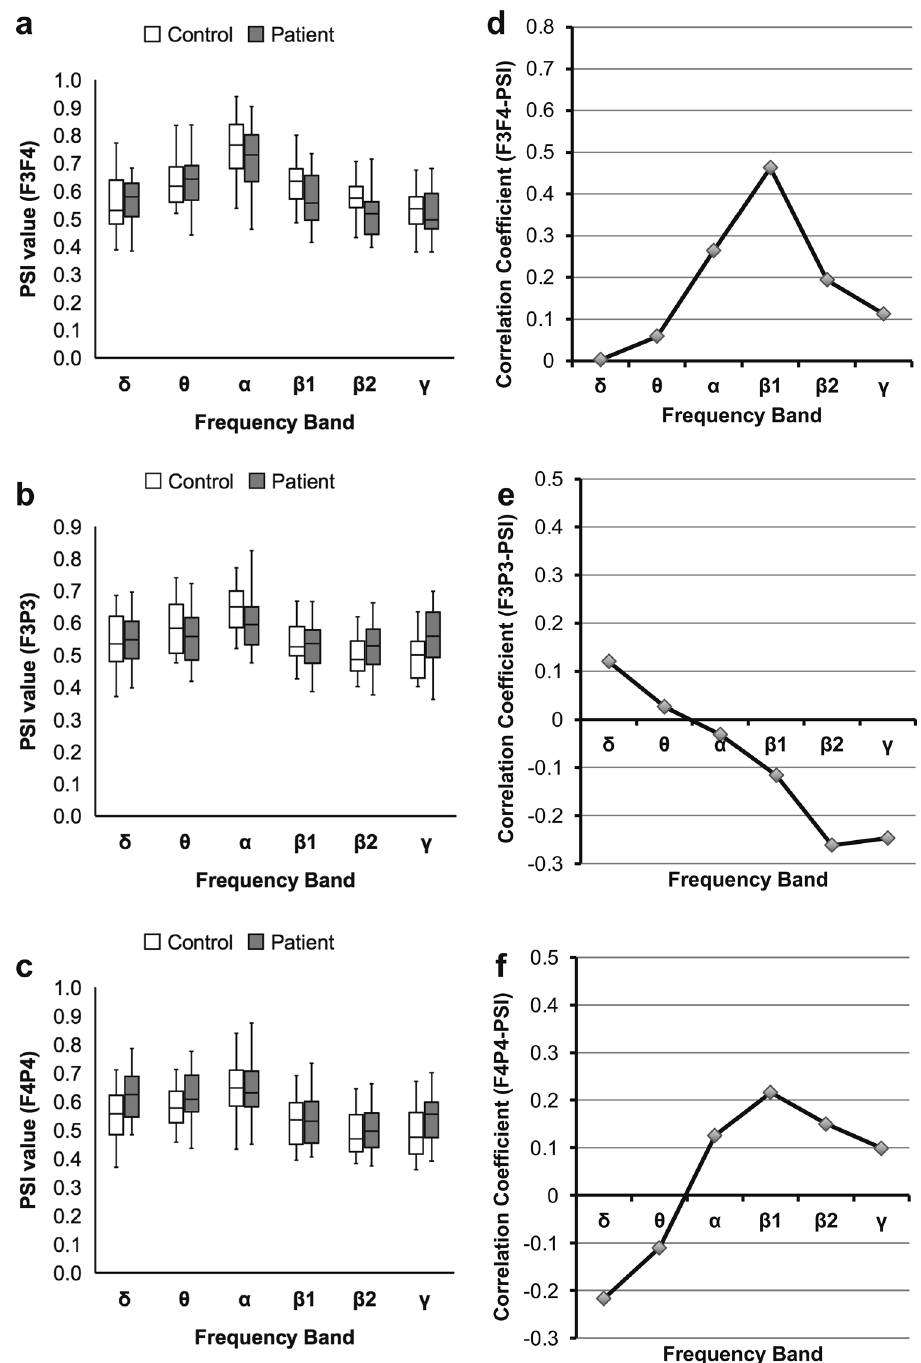
Figure 4. Results of analyses for the spatially adjacent PSIs. Comparison of PSIs in stroke patients with those in healthy controls. A box-and-whisker plot indicating values of the ( a ) F3F4-PSI, ( b ) F3P3-PSI, and ( c ) F4P4-PSI of stroke patients and healthy controls (Mann ‒ Whitney U test, FDR corrected). In contrast to the PSIs between motor language-related regions, all spatially adjacent PSIs show no significant difference between stroke patients and healthy controls. Correlation coefficients of the F3F4/F3P3/F4P4-PSIs with ARSsp scores. A polygonal line graph of the correlation coefficients for the correlation of ( d ) F3F4-PSI, ( e ) F3P3-PSI, and ( f ) F4P4-PSI with ARSsp scores (Spearman’s correlation analysis, FDR corrected). In contrast to the PSIs between motor language- related regions, all spatially adjacent PSIs show no significant correlations in any frequency band. ARSsp Aphasia Rating Scale speech, FDR false discovery rate, PSI phase synchrony